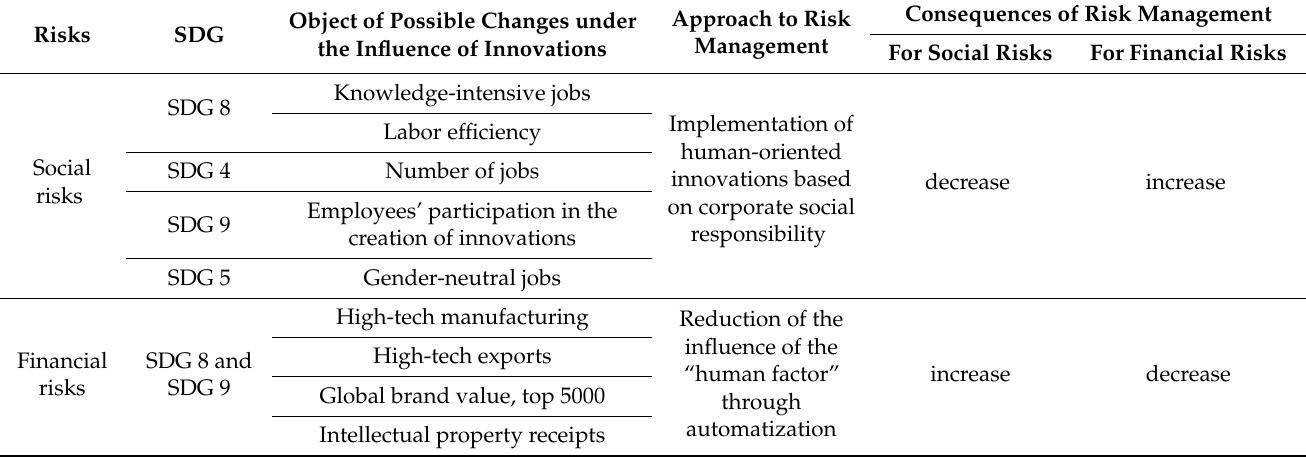
Table 3. The systemic view of social and financial risks of managing the investments in innovations and the consequences of risk